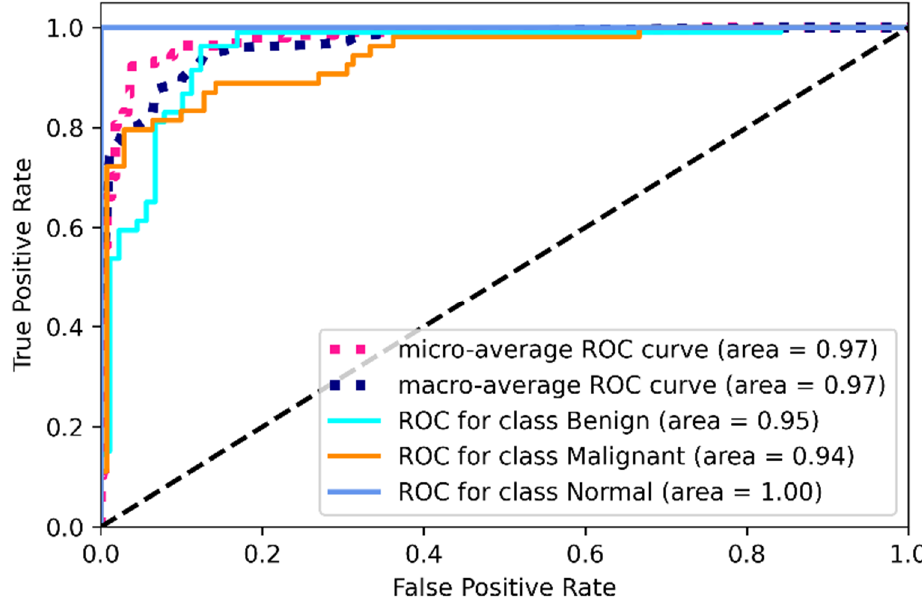
Figure 14. ROC for combined image evaluation (on training data).